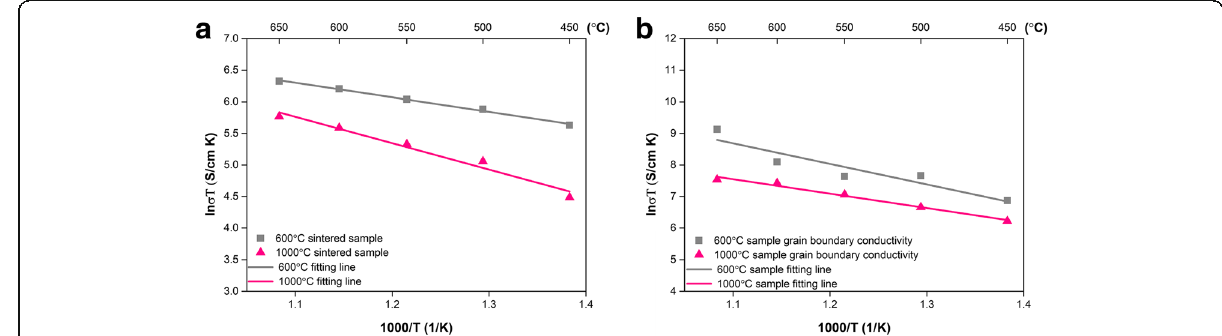
Fig. 6 The Arrhenius plots of pellet sintered at 600 °C compared to that of pellet obtained at 1000 °C in a total conductivity and b grain boundary